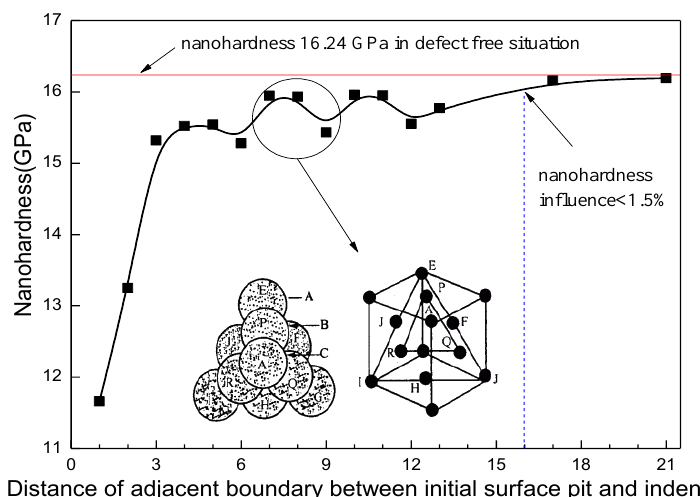
Figure 4. Nanohardness vs. distance of adjacent boundary between the pit and indenter. However, the first three atoms, respectively d = 1d 0 , d = 2d 0 , d = 3d 0 distance, do not match distribution of Al crystal are